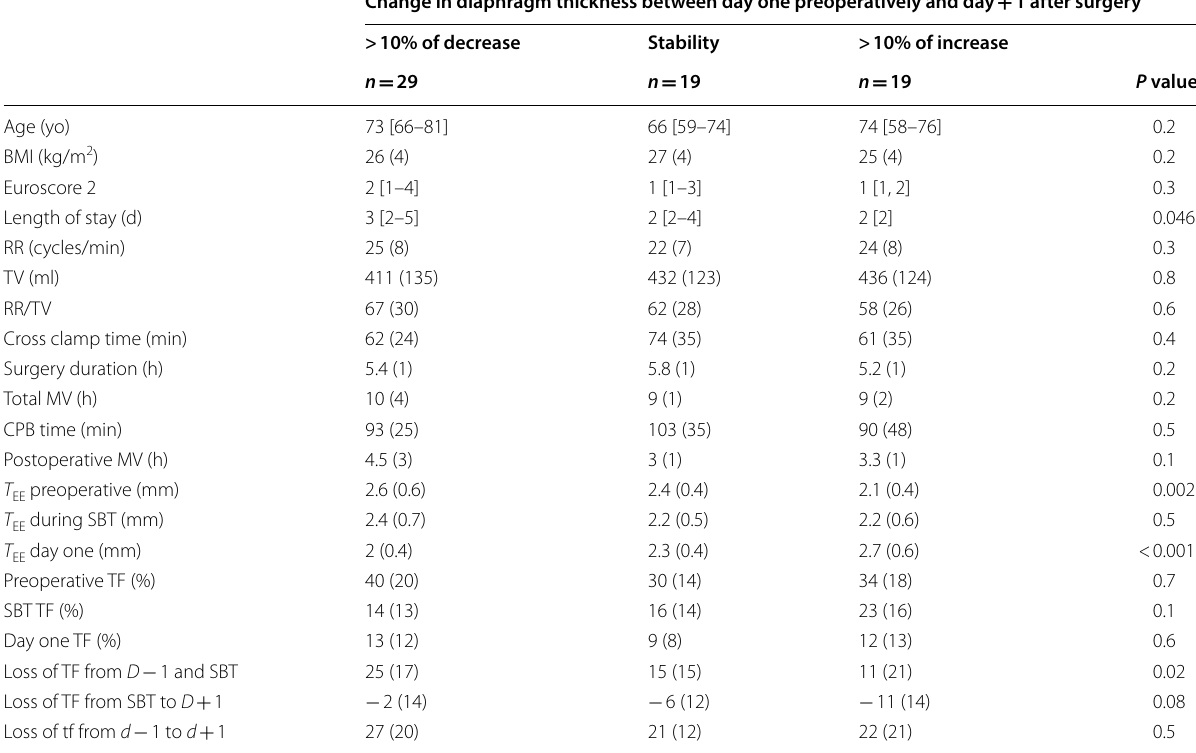
Table 3 Demographic, preoperative and diaphragm variables associated to the change in diaphragm thickness Change in diaphragm thickness between day one preoperatively and day